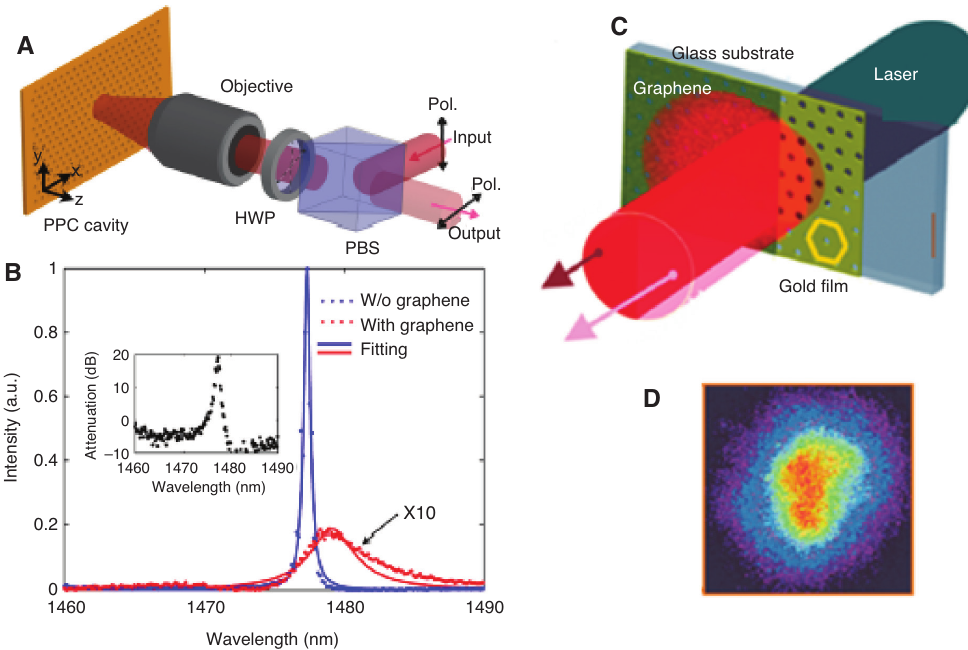
Figure 5: SHG measurement results of graphene-cavity structure [136]. (A) Cross-polarization confocal microscope. HWP, half-wave plate; PBS, polarized beam splitter. (B) Reflection before and after the deposition of graphene. Inset: attenuation of the cavity with graphene [136]. (C) Schematic of SHG measurements in transmission mode in graphene/ gold nanohole array/glass substrate structure. (D) The SHG image is collected for the graphene-coated sieve by a CCD camera [137].